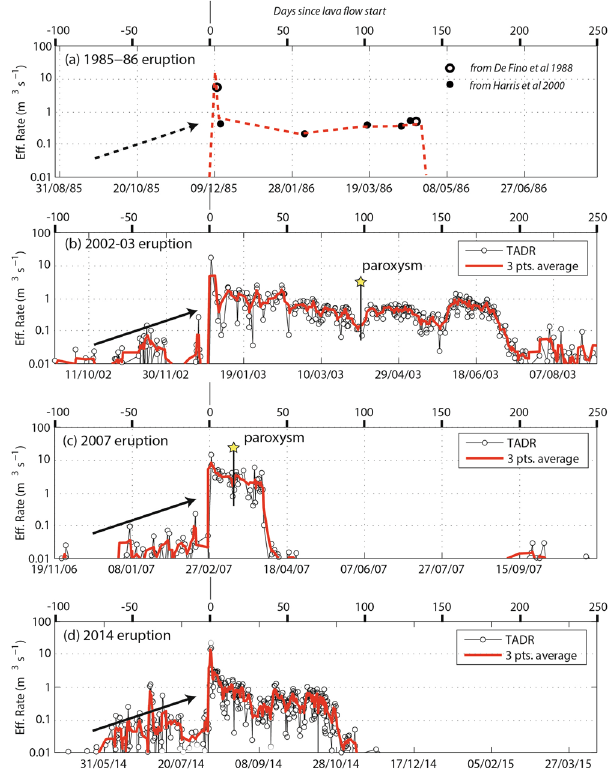
Figure 2. Effusive trends relative to the ( a ) 1985, ( b ) 2003, ( c ) 2007 and ( d ) 2014 eruptions of Stromboli. The datasets are represented on the logarithmic scale and were derived from the literature 30, 38 ( a ) and MODIS data 25, 29, 31, 32, 34 ( b – d ). The time-series span from day − 100 to day + 250, with day 0 representing the beginning of each eruption. The red lines outline the main trends, all of which are characterized by a sharp increase at the eruption onset, followed by a general decline of effusion rates toward the end the eruptions. The yellow stars mark the occurrence of the two paroxysms that occurred on 5 April, 2003, and 15 March, 2007, respectively. Note the general increase of the output rates recorded during the weeks preceding the onset of each eruption (black